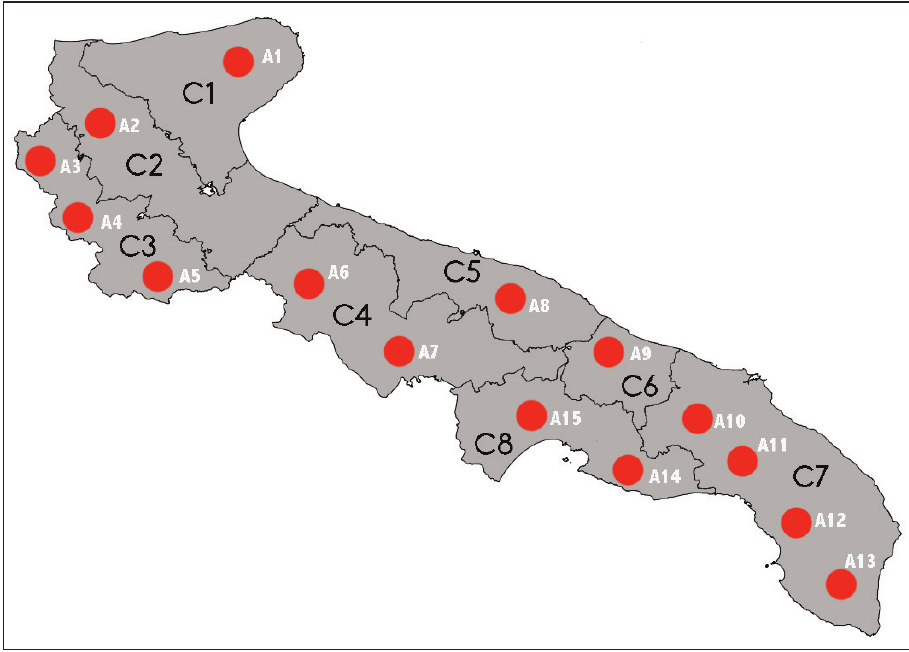
Figure 2. In the background the Apulian districts: Gargano ( C1 ), Tavoliere delle Puglia ( C2 ), Dauni Mountains for the province of Foggia ( C3 ); Land of Bari murgiana ( C4 ) and Terra di Bari ( C5 ) for the province of Barletta-Andria-Trani and Bari; Valle d’Itria ( C6 ) and Salento for the province of Brindisi and Lecce ( C7 ); Ionic tarantine arch for the province of Taranto ( C8 ). In the foreground red areas the study areas (15) for each